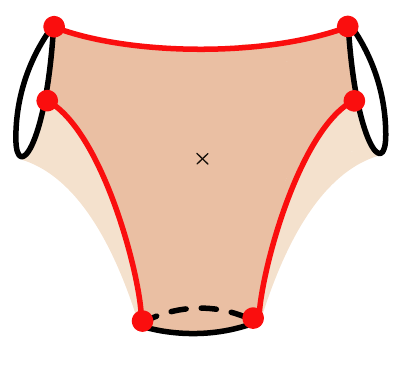
constructed by gluing two Euclidean black holes of bh